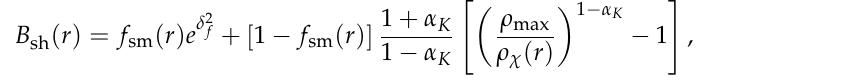
+ B f 2 sh . The bottom sh −